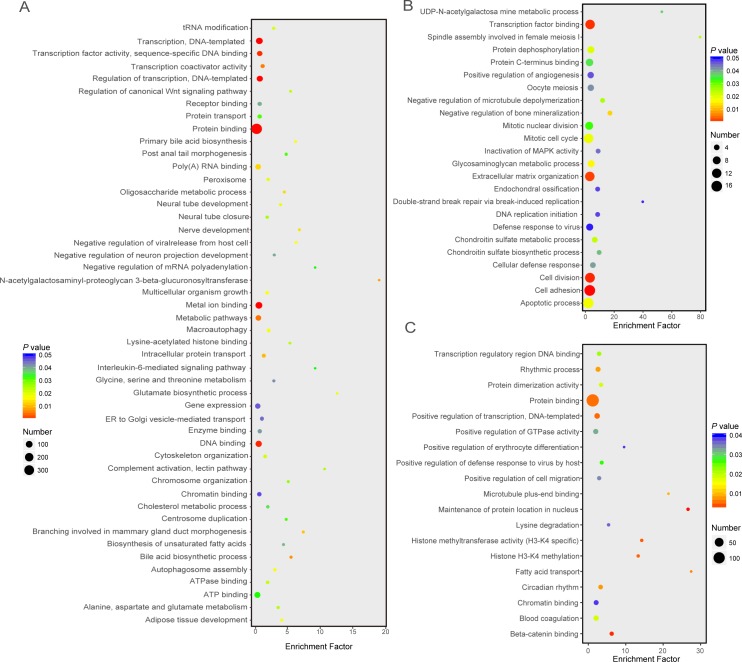
GO terms of genes showing a higher enrichment of m6A methylation in newborn (A), suckling (B) and adult (C). Different colors represent P values, and sizes represent gene numbers. X-axis represents fold enrichment.